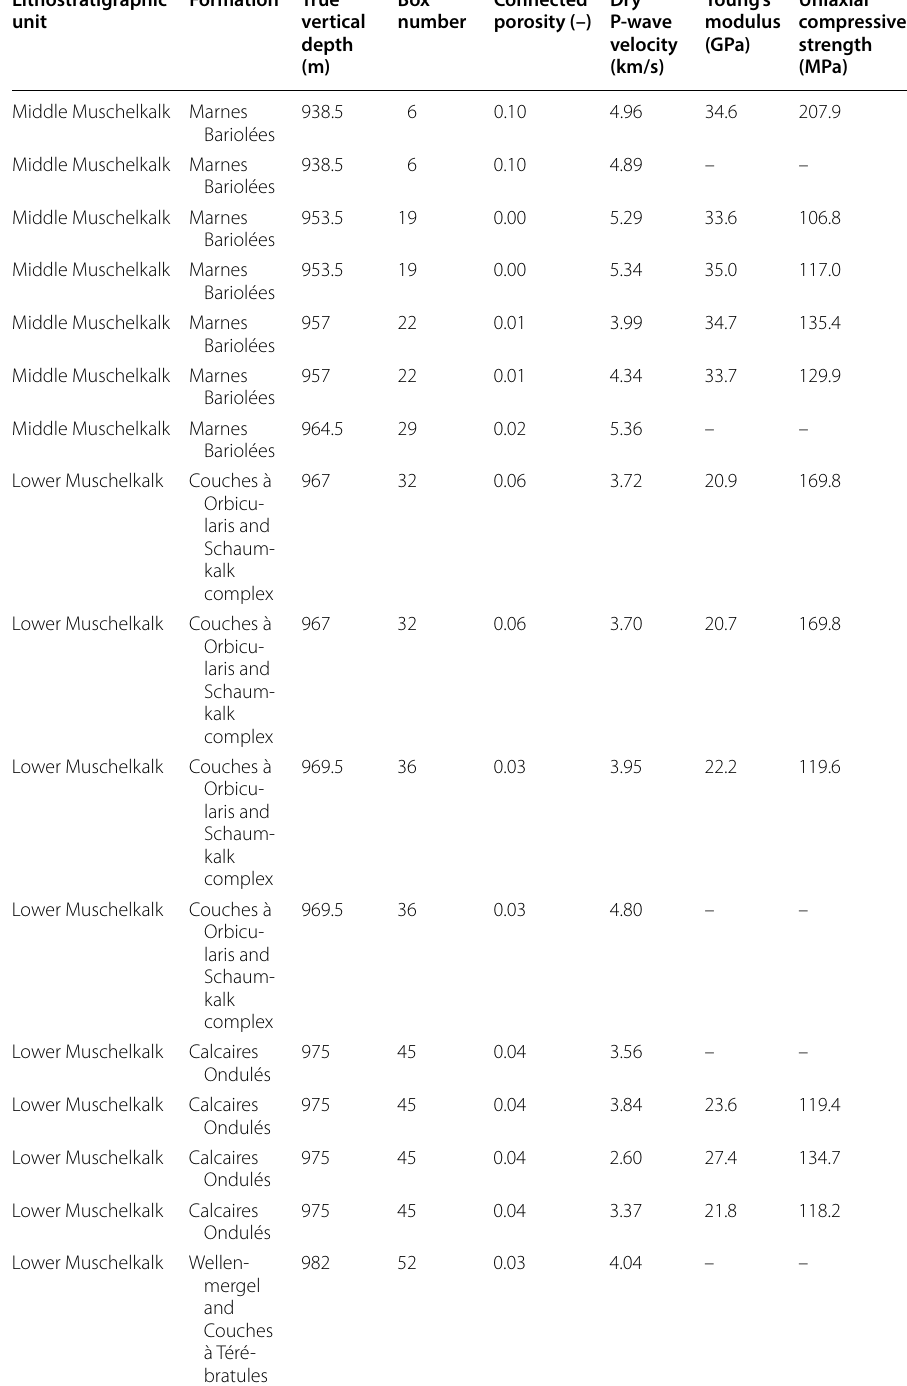
Table 2 Summary of the laboratory data (connected porosity, P-wave velocity, Young’s modulus, and uniaxial compressive strength) collected for the fifteen depths sampled in the Muschelkalk at exploration well EPS-1 (Soultz-sous-Forêts), and three depths sampled in the Buntsandstein at the Muschelkalk–Buntsandstein interface Lithostratigraphic Formation True Box Connected Dry unit vertical number porosity (–) depth (m)